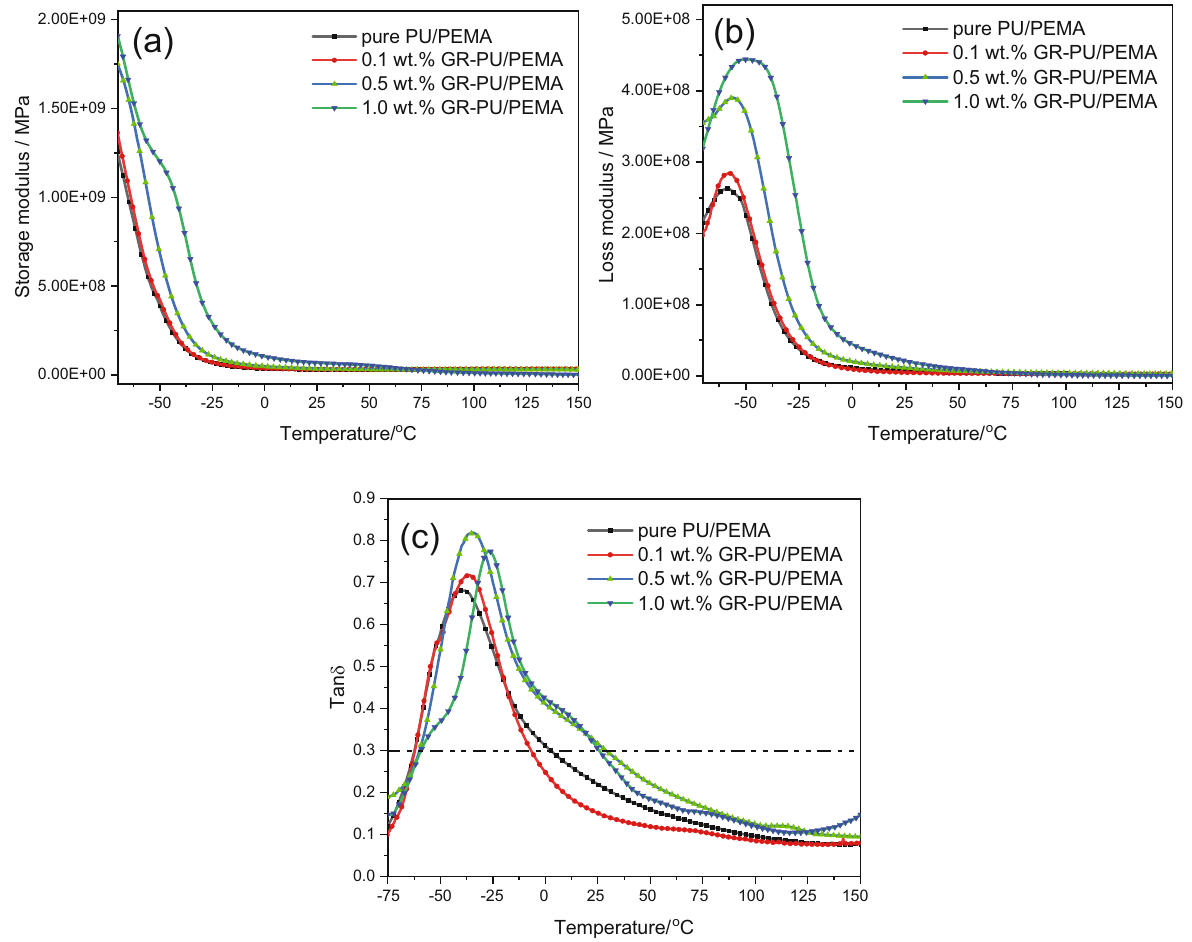
Figure 7: Temperature dependence of ( a ) storage modulus, ( b ) loss modulus, and ( c ) tan σ for pure PU/PEMA, 0.1 wt% GR - PU/PEMA, 0.5 wt% GR - PU/PEMA, and 1.0 wt% GR -